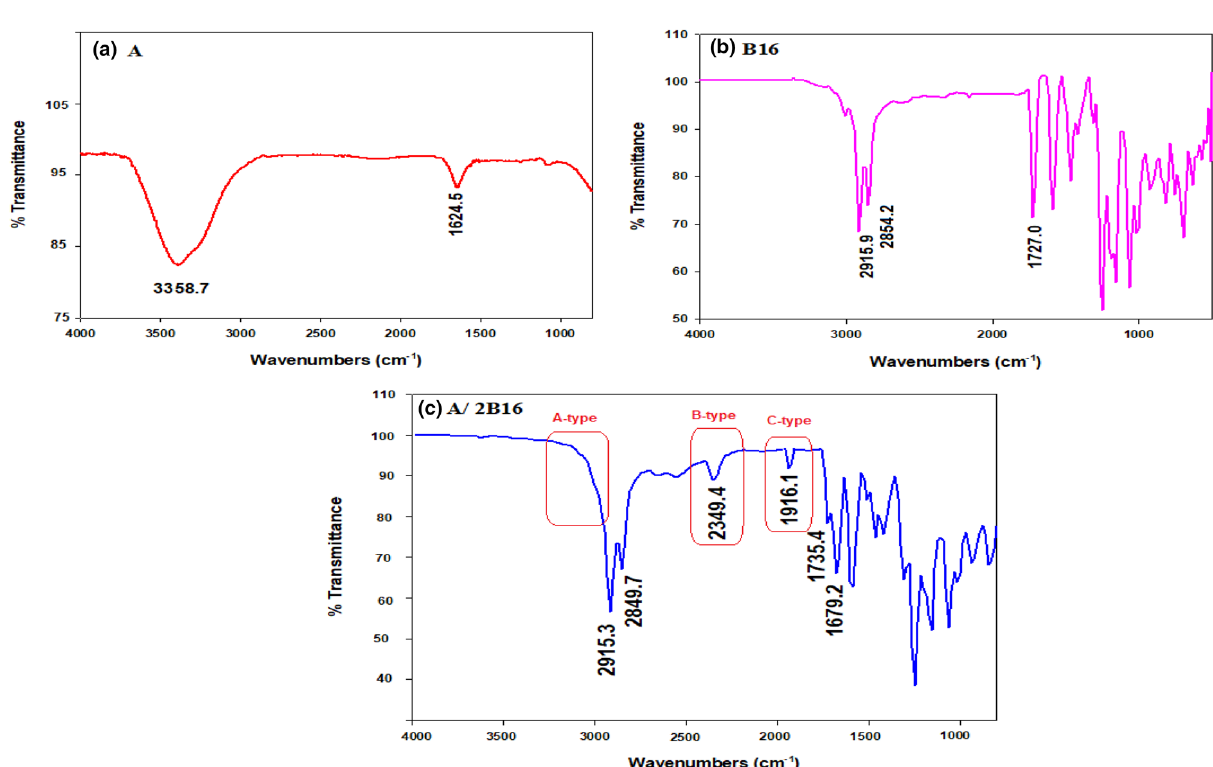
Figure 1. FT-IR spectra of ( a ) Adipic acid, A ; ( b ) Azopyridine, B16 and ( c ) their supramolecular H-bonded complex A/2B16